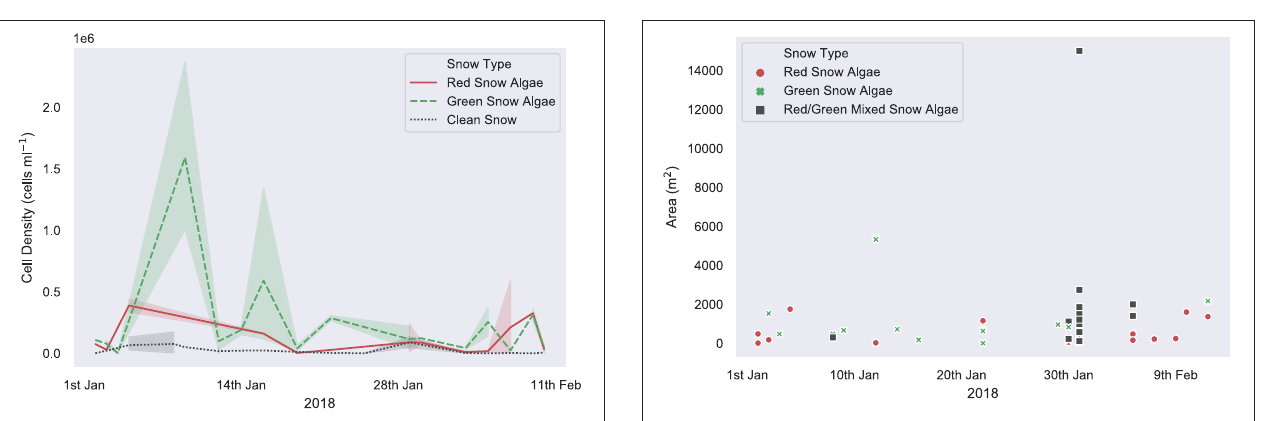
green snow algae spectra reported elsewhere (Painter et al., 2001; Holzinger et al., 2016; Huovinen et al., 2018; Khan et al., 2021). There was significant variation in the magnitude of HDRF within the visible/near infra-red (VNIR) region, as our sampling aimed to survey a wide range of cell densities to avoid extrapolation when applying our regression model to remotely sensed images. Lower cell concentrations, where coloration was just visible on the surface of the snow, typically had higher overall reflectance and a smaller chlorophyll absorption features at 680 nm. Where algae completely covered the snow surface, HDRF values were much lower within the VNIR range but relationship between cell density and the continuum-scaled integral of the chlorophyll a absorbance feature is shown in Figure 4 . The linear relationship between cell density and I B 5 ( Figure 4 ) was high and significant for both red and green blooms, with respective Pearson’s correlation coefficients of r (58) = 0.82, p < 0.01 and r (55) = 0.80, p < 0.01. R 2 was, respectively, 0.67 and 0.64, and the standard error 4.3 × 10 4 and 2.5 × 10 4 cells ml − 1 . The lines of best fit, used to estimate cell density within a WorldView pixel, are shown in Equations (3) and (4), for red and green snow algae, respectively.